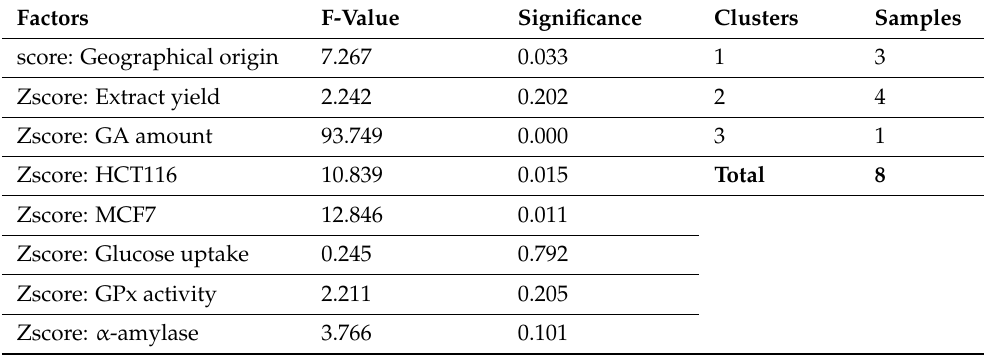
Table 5. K-mean analysis for different geographical samples of